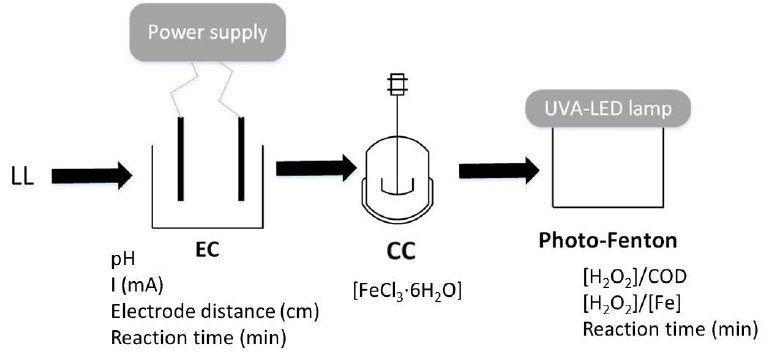
Figure 1. Schematic representation of the full optimized treatment strategy.